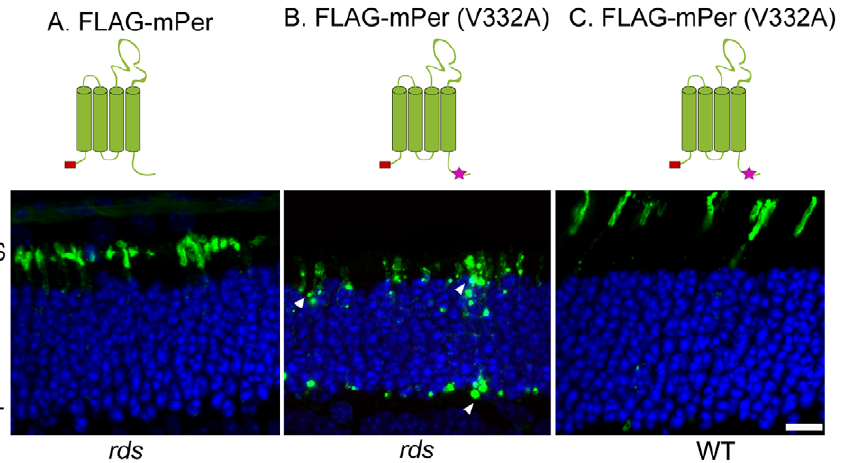
Figure 4. The V332A mutation abrogates peripherin’s outer segment targeting in rods of the rds mouse. (A) Wild type FLAG-tagged mouse peripherin (mPer) was electroporated into rods of the rds mouse and stained with anti-FLAG antibodies (green). (B) V332A FLAG-tagged peripherin electroporated into rods of the rds mouse; construct mislocalization to the inner segment and synaptic terminal is highlighted by white arrowheads. (C) V332A FLAG-tagged peripherin electroporated into the rods of wild type mice. The electroporated constructs are illustrated schematically above the corresponding panels with the position of the FLAG tag depicted in red. Note that the outer segment shapes in (A) and (C) are different due to ongoing photoreceptor degeneration in the rds mouse (A). Abbreviations are: OS – outer segment, IS – inner segment, N – nuclei, ST – synaptic termini. Nuclei (blue) are stained with Hoechst. Scale bar: 10 m m.